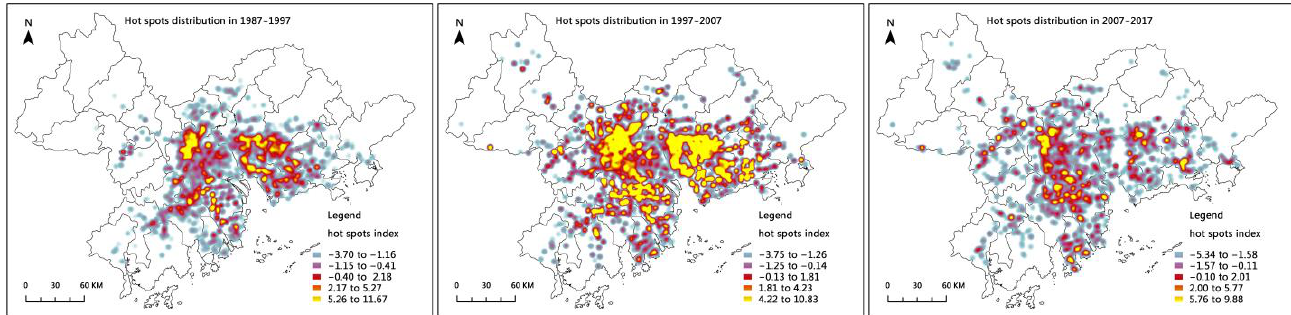
Figure 8. Hot spots distribution of manufacturing production space expansion in